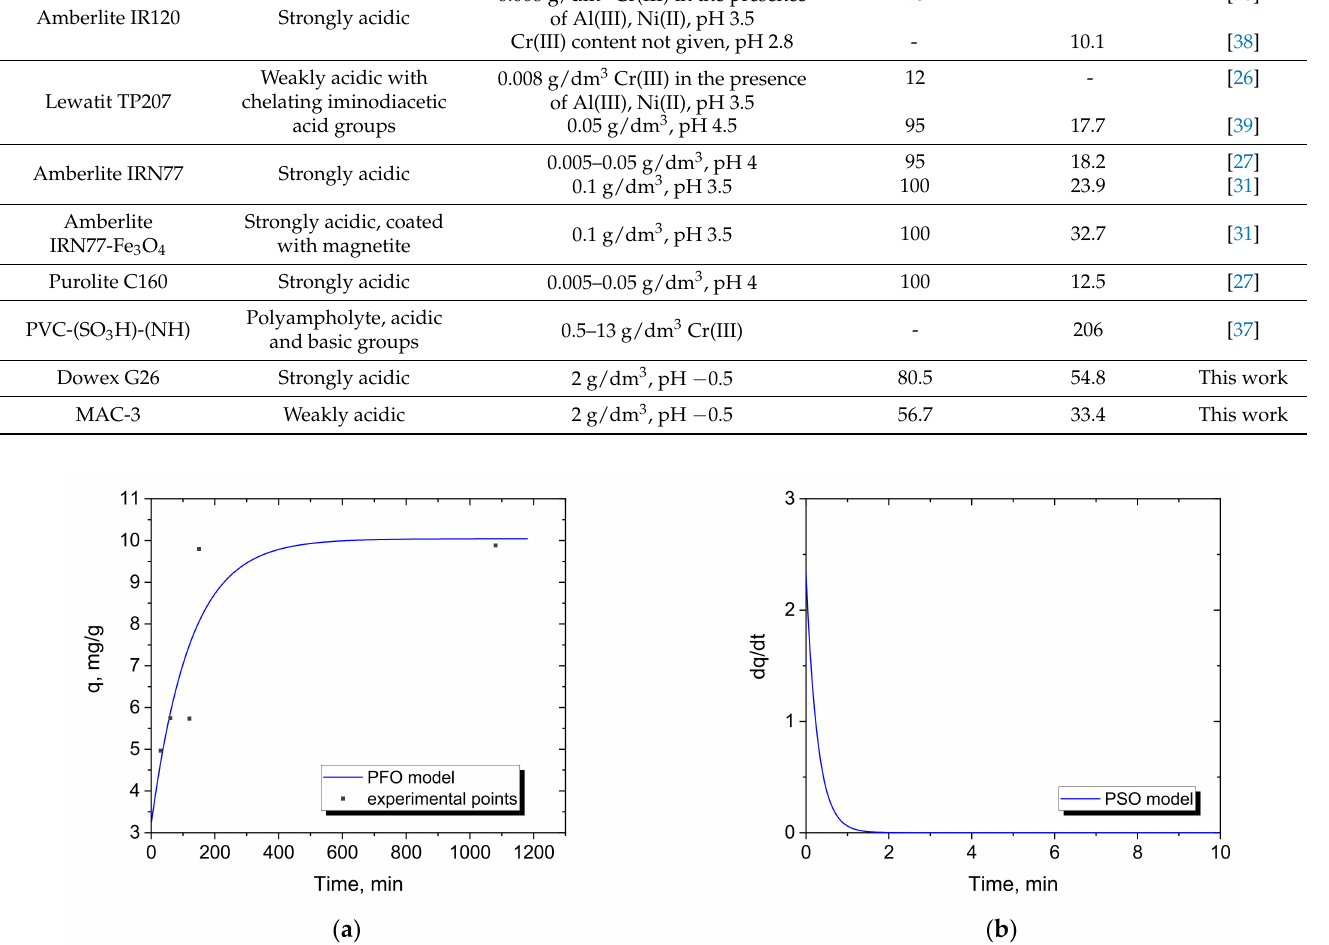
Figure 7. Experimental data for Cr(III) adsorption with 250 mg of MAC-3 with double exponential function for calculation of ( a ) PFO and ( b ) PSO kinetic models and the adsorption rate (feed: 2 g/dm 3 Cr(III) solution at pH −